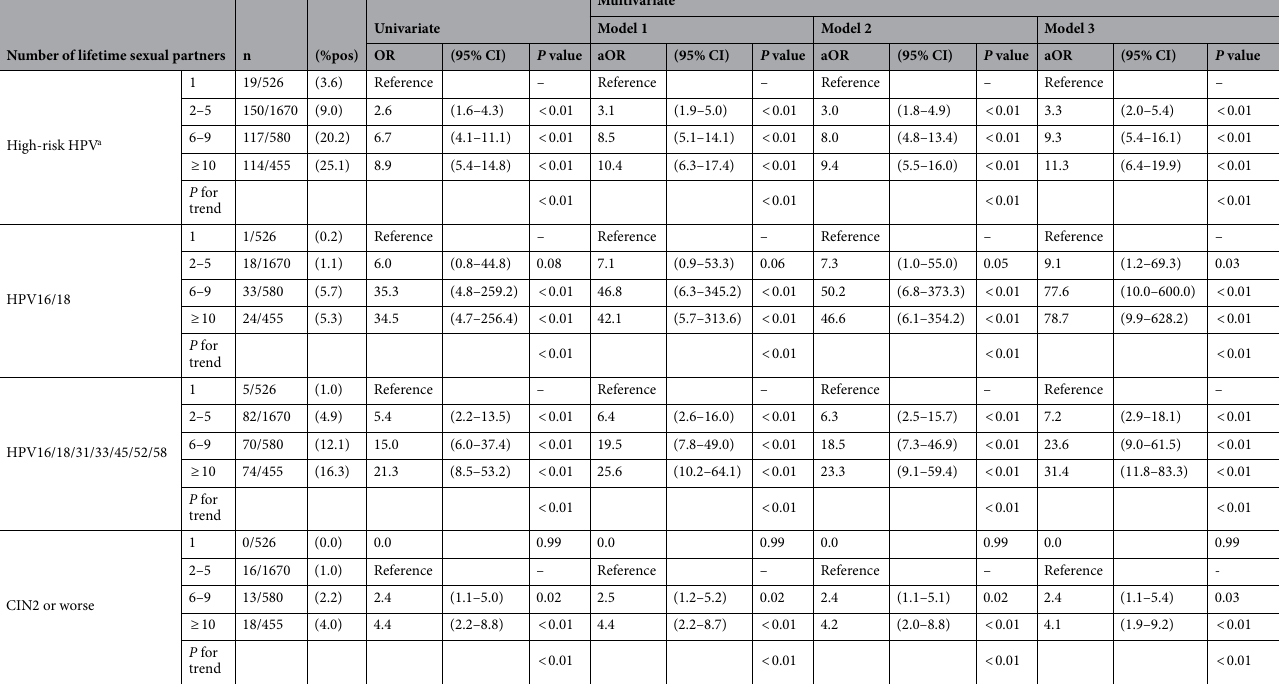
Table 4. Correlation between number of lifetime sexual partners, rates of HPV infection and high-grade cervical disease (CIN2 or worse). CIN cervical intraepithelial neoplasia, OR odds ratio, aOR adjusted odds ratio. Model 1 adjusted for age. Model 2 adjusted for age and smoking history. Model 3 adjusted for age, smoking history and age at first intercourse. a HPV16/18/31/33/35/39/45/51/52/56/58/59/68 (HC2).